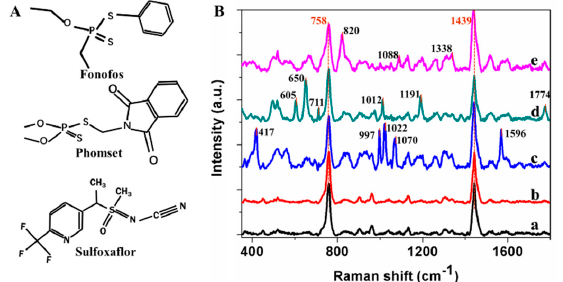
Figure 2. The chemical structures ( A ) of fonofos, phosmet, and sulfoxaflor, and the surface-enhanced Raman spectroscopy (SERS) spectra ( B ) of GNRs ( a ), paddy water ( b ), fonofos ( c ), phosmet ( d ), and sulfoxaflor ( e ).